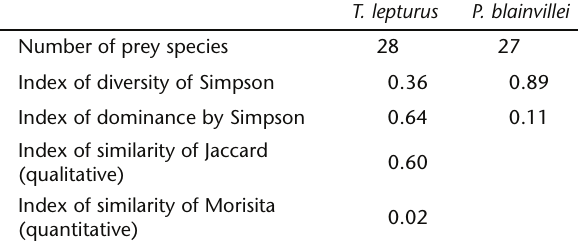
Table III. Comparison between the diet of T. lepturus and P. blainvillei in northern Rio de Janeiro through ecological indexes (indexes values range from 0 to